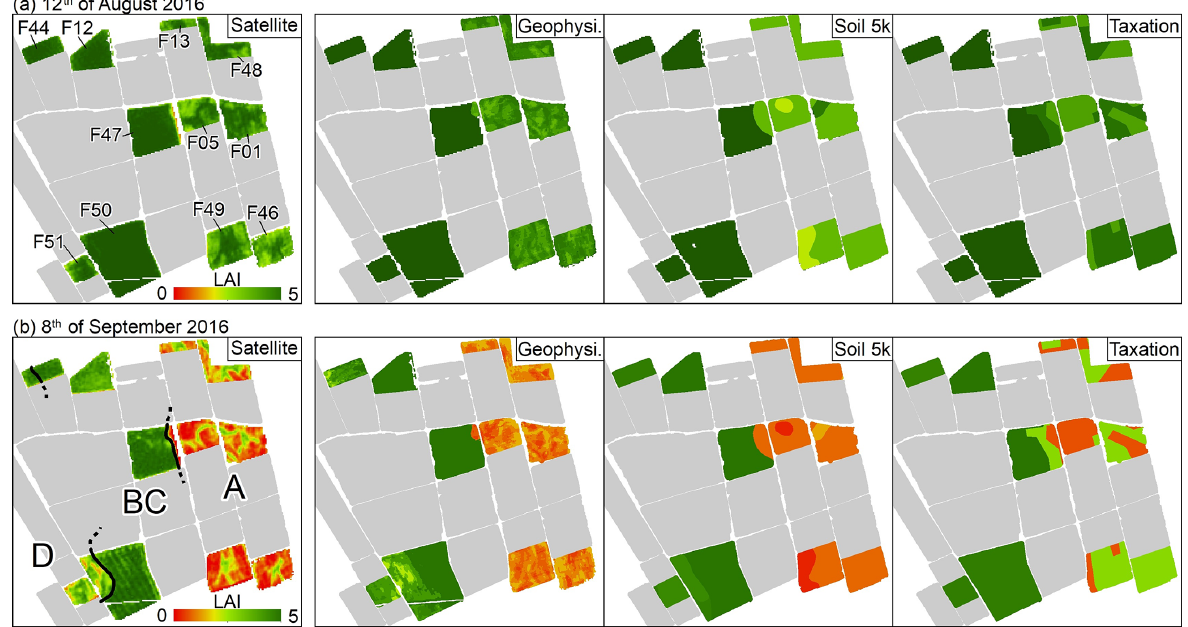
Figure 9. Observed LAI NDVI and simulated LAI obtained using input from the geophysics-based soil map (Geophysi.), the 1:5000 soil map (Soil 5k), and the soil taxation map (Taxation); row (a) shows the codes of the investigated fields and the comparison on 12 August 2016, and row (b) shows the geometry of sub-areas A, BC, and D and the comparison on 8 September